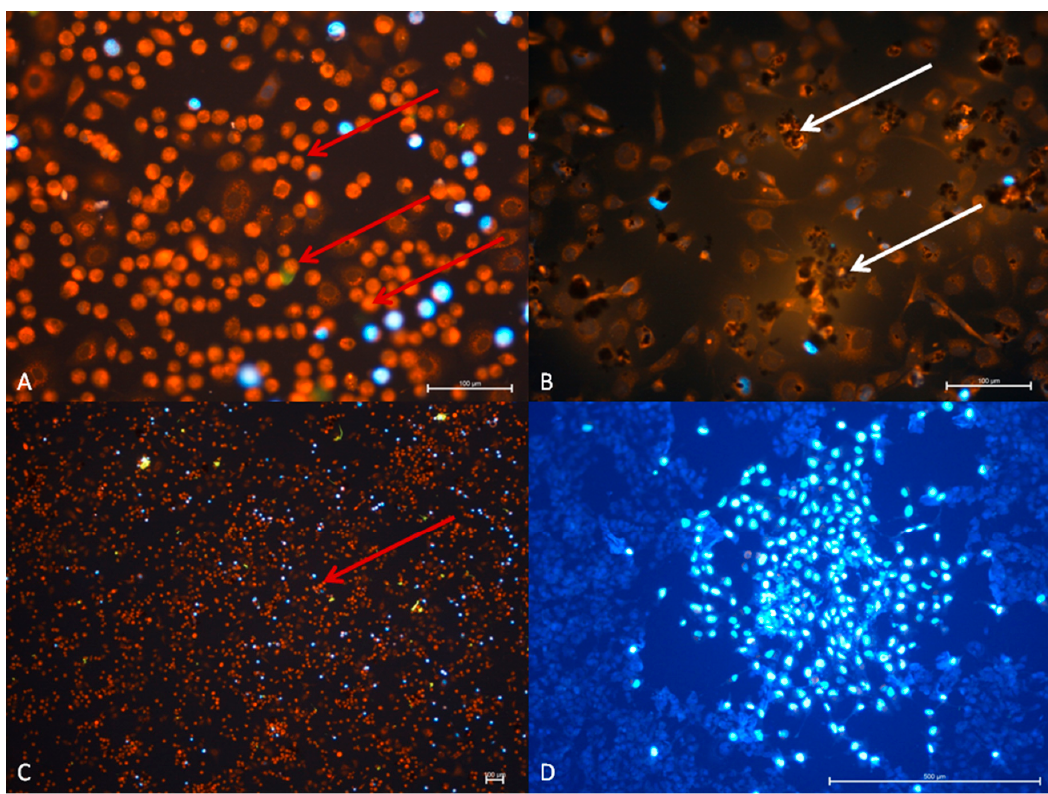
Figure 10. TC28a2cell line. ( A ) Group RuV, ( B ) GO group, ( C ) RuV group, ( D ) GO + RuV group. Visible changes in cell morphology after administration of virus and graphene +virus. In TC28a2 (C and D picture) cell line after 48 h after virus and graphene + virus administration increased cytopathic effect was noted. Note numerous changes in cell morphology after virus administration and reduced positive cells number in response to DAPI after 48 h (red arrow). The positive cells are located in colonies among cytopathic cells (D picture). Graphene positive cells maintain the shape of the TC28a2 cell line. DAPI + Rhodamine B. A and B—Mag 200x, C ‐ 40x, D ‐ 100x.